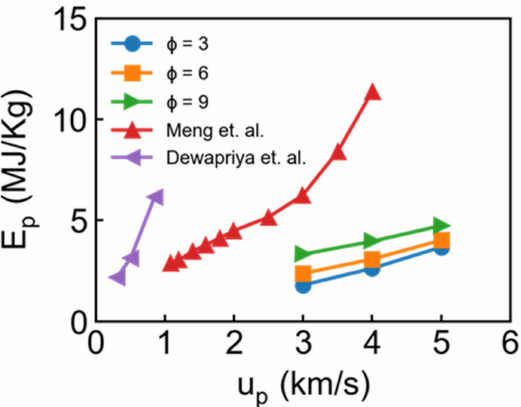
Figure 7. Relation between u p and specific penetration energy E p for different draw ratio. The red points and purple points come from works reported by Meng et al. [30] and Dewapriya et al. [31], respectively.